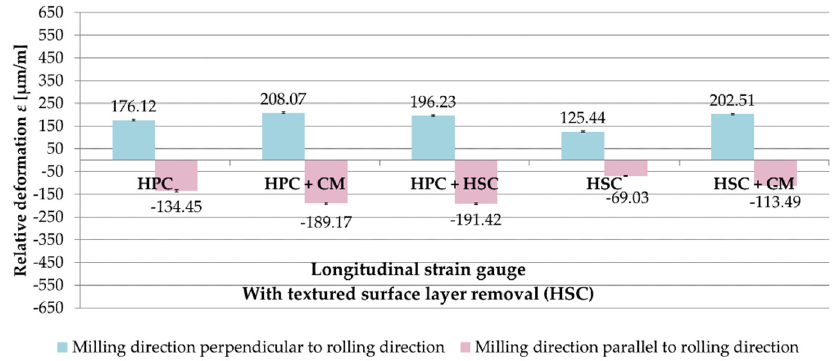
Figure 11. Comparison of relative deformations ε obtained on longitudinal strain gauges, depending on the relation of the milling direction to the rolling direction (samples with the removed surface layer—HSC).